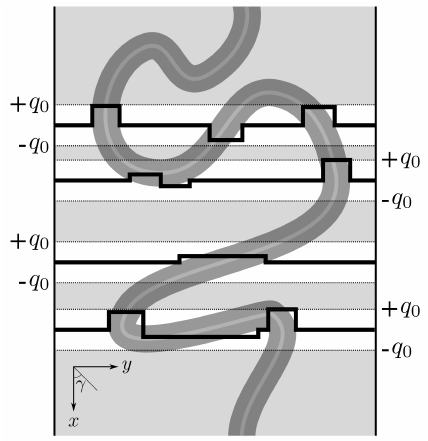
Figure B2. Down-valley discharge of water and sediment in each cross section is equal, and equals the down-channel discharge. Here, this is demonstrated geometrically, and results from discharge per unit width decreasing as the flow becomes more oblique to the val- ley cross section line, but the fraction of the total cross-valley line occupied by river channel increases in an inversely proportional manner. This remains true even for up-valley flow, which must be balanced with down-valley flow for water to be able to move from the upstream to the downstream ends of the valley. The direct down- valley discharge of water or sediment per unit width is given by q 0 . In this schematic, discharge is given by a set of boxcar-function ap- proximations (mean discharge across width) for the sake of simple illustration. While we use a single-thread river for simplicity, this same relationship holds for partitioning of flow and sediment trans- port across a multi-thread